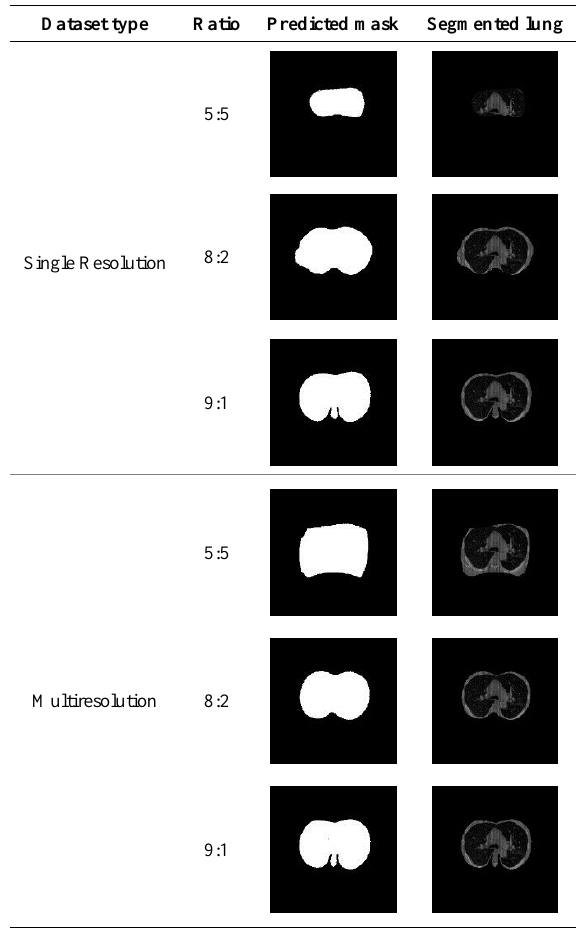
Table 4. Segmentation